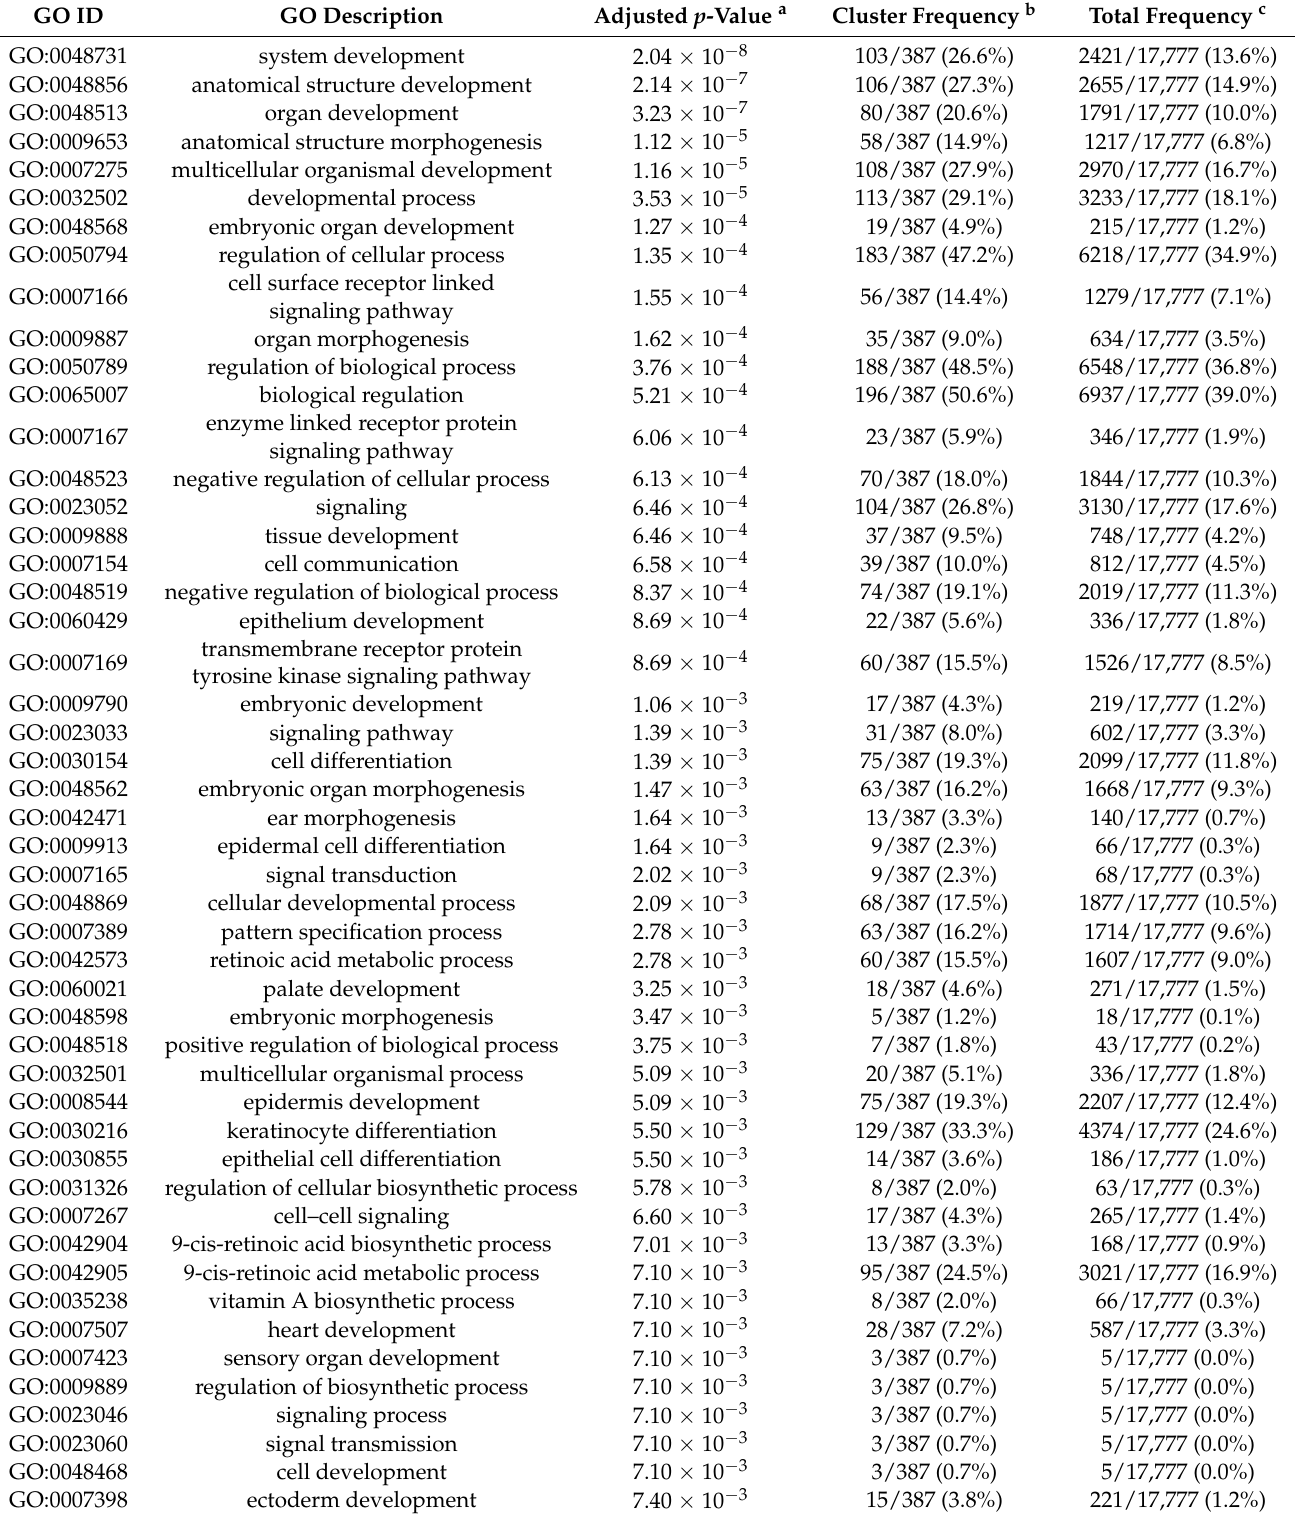
Table 1. Gene ontology (GO) enrichment analysis of differentially expressed genes in HT-29 stimu- lated with